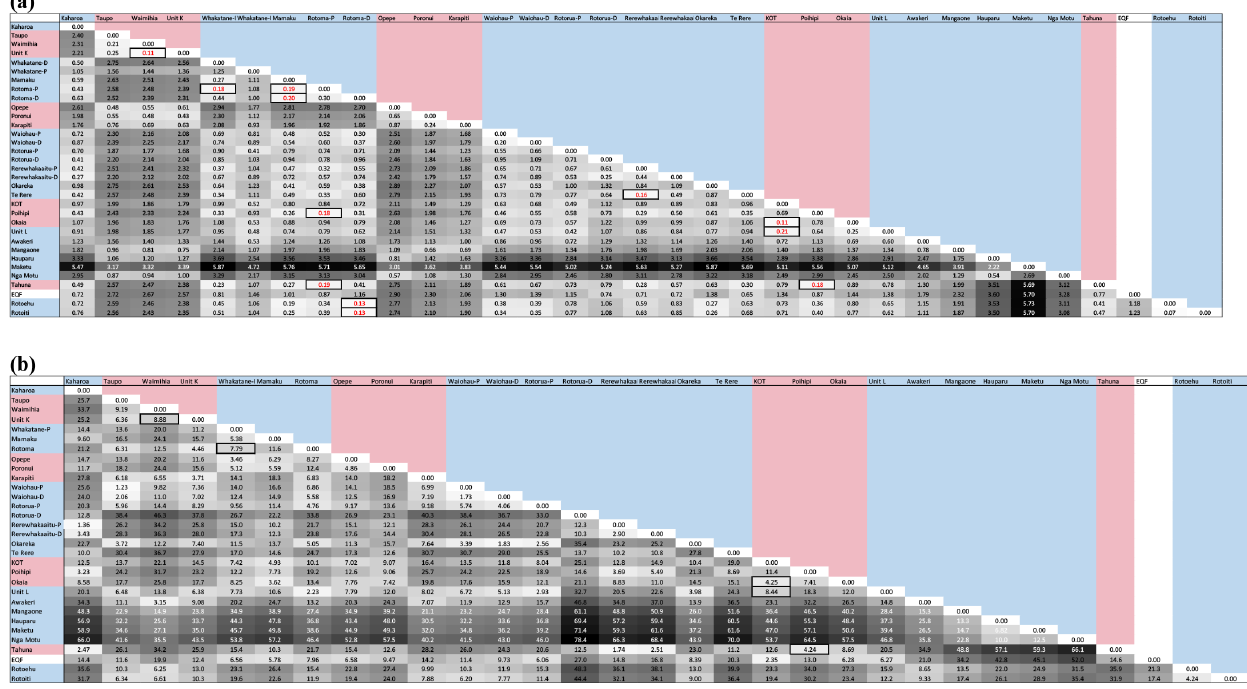
Table 3. Results of Euclidean similarity coefficient (ESC) calculations for major-element (a) and trace-element (b) concentrations in glass from all the tephras analysed. See Supplement Material 2 for R code used for these calculations. Colour coding shows ESC values: white shows the smaller the value (similar compositions) through to black showing the larger the values (different compositions). The lowest values ( < 0.2) and hence the most similar tephras compositionally (based on Al 2 O 3 , K 2 O, SiO 2 , Na 2 O, TiO 2 , FeO t t , and MnO major elements and V, Co, Rb, Nd, Eu, Yb, Th, and U trace elements) are highlighted with bold outlines and red text. Tephras from Taup¯o Volcanic Centre are shaded red, and those from Okataina Volcanic Centre are shaded